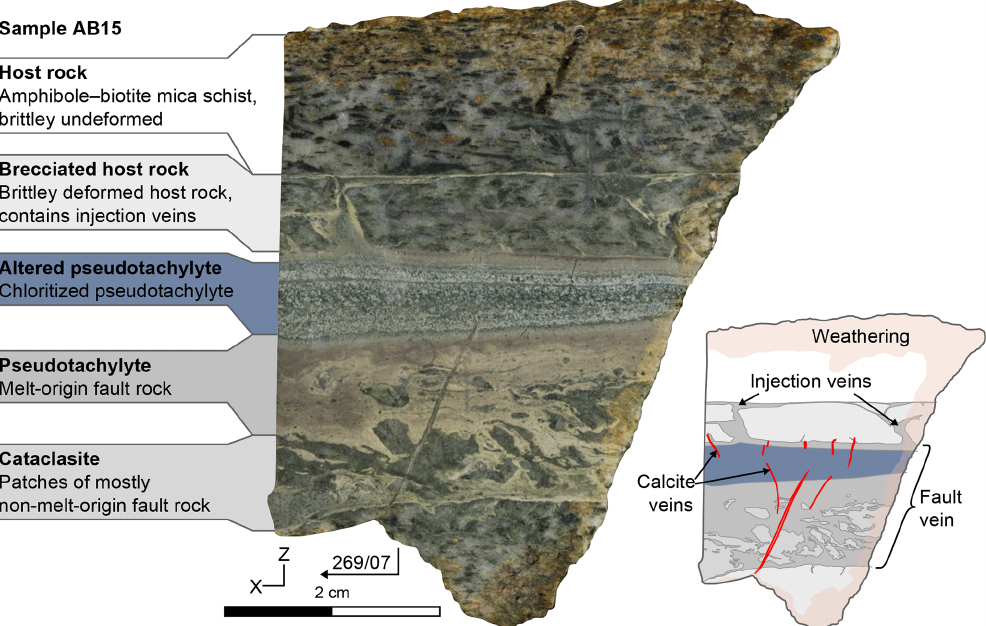
Figure 3. Macroscopic appearance of sample AB15, showing the different kinds of faulted rock in the studied sample (i.e., brecciated host rock, altered pseudotachylyte, pseudotachylyte and cataclasite); characterization of fault rock types is based on microscopic observations. The inset figure shows interpreted structures in the fault. The image represents the XZ plane of the finite strain ellipsoid, where X is parallel to the stretching lineation and Z is normal to the foliation